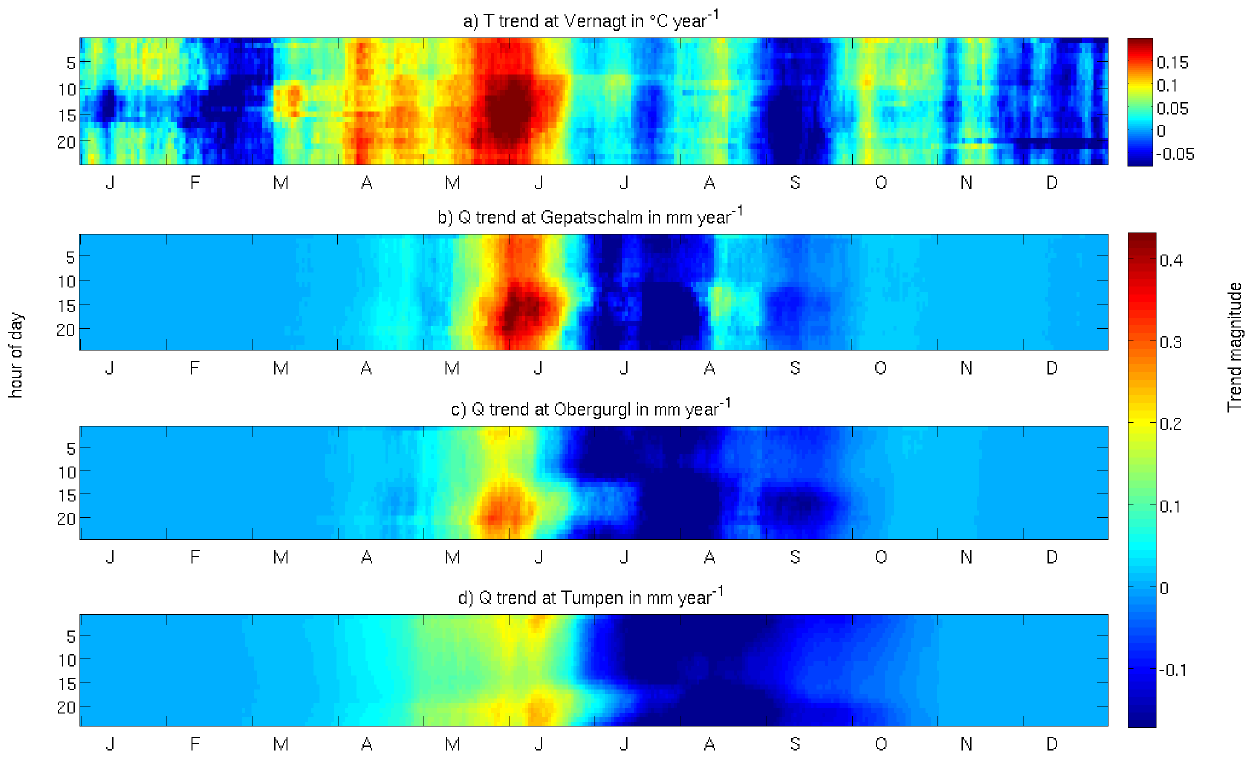
Figure 7. Seasonal distribution of hourly trend magnitudes (1985–2010): (a) T at Vernagt; (b) Q at Gepatschalm; (c) Q at Obergurgl; (d) Q at